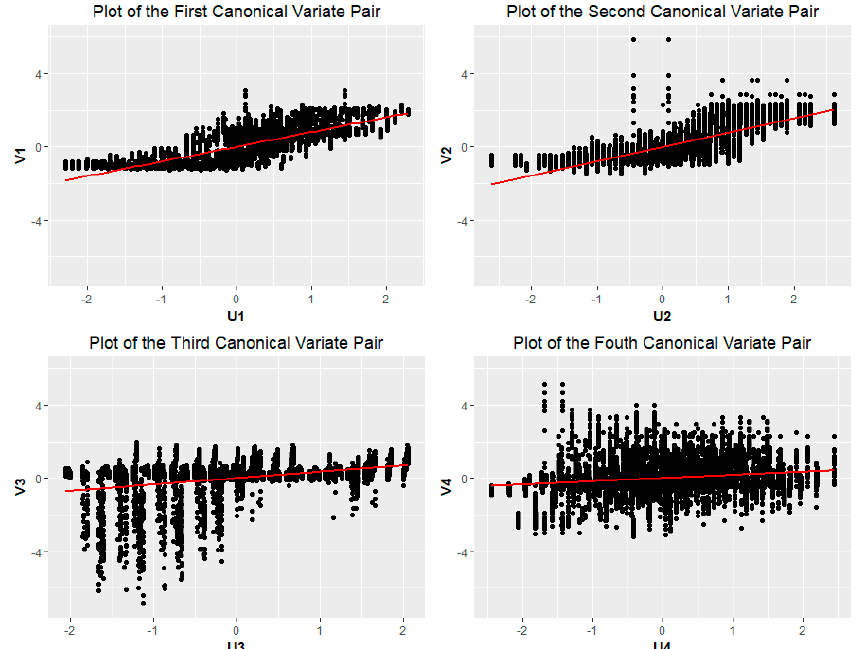
Figure 2. The scatter plots for each canonical variate pair with the fitted regression line.